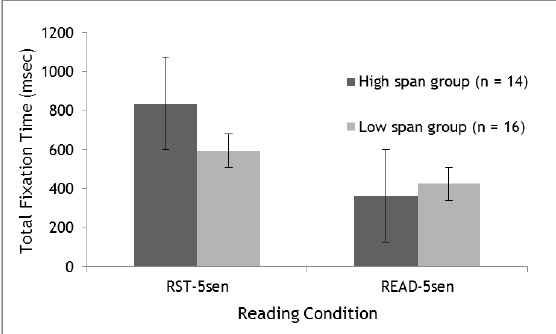
Figure 4. Total fixation time (s) for the high-span group and low-span group for READ and RST under the five-sentence